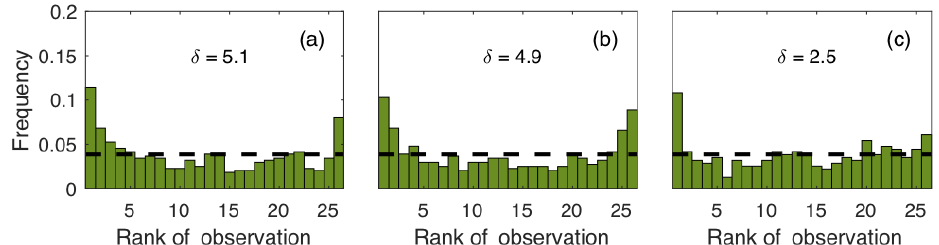
Figure A1. Rank histograms of the 25-member ensemble after calibration for wind speed (a) , wind direction (b) and planetary boundary layer height (c) over 35d (18 June to 21 July 2008) using 14 rawinsonde sites available over the US Midwest. The horizontal dashed line corresponds to the ideal value for a flat rank histogram with respect to the number of members. The rank histogram score ( δ ) defines the flatness of the rank histogram, 1 being the ideal